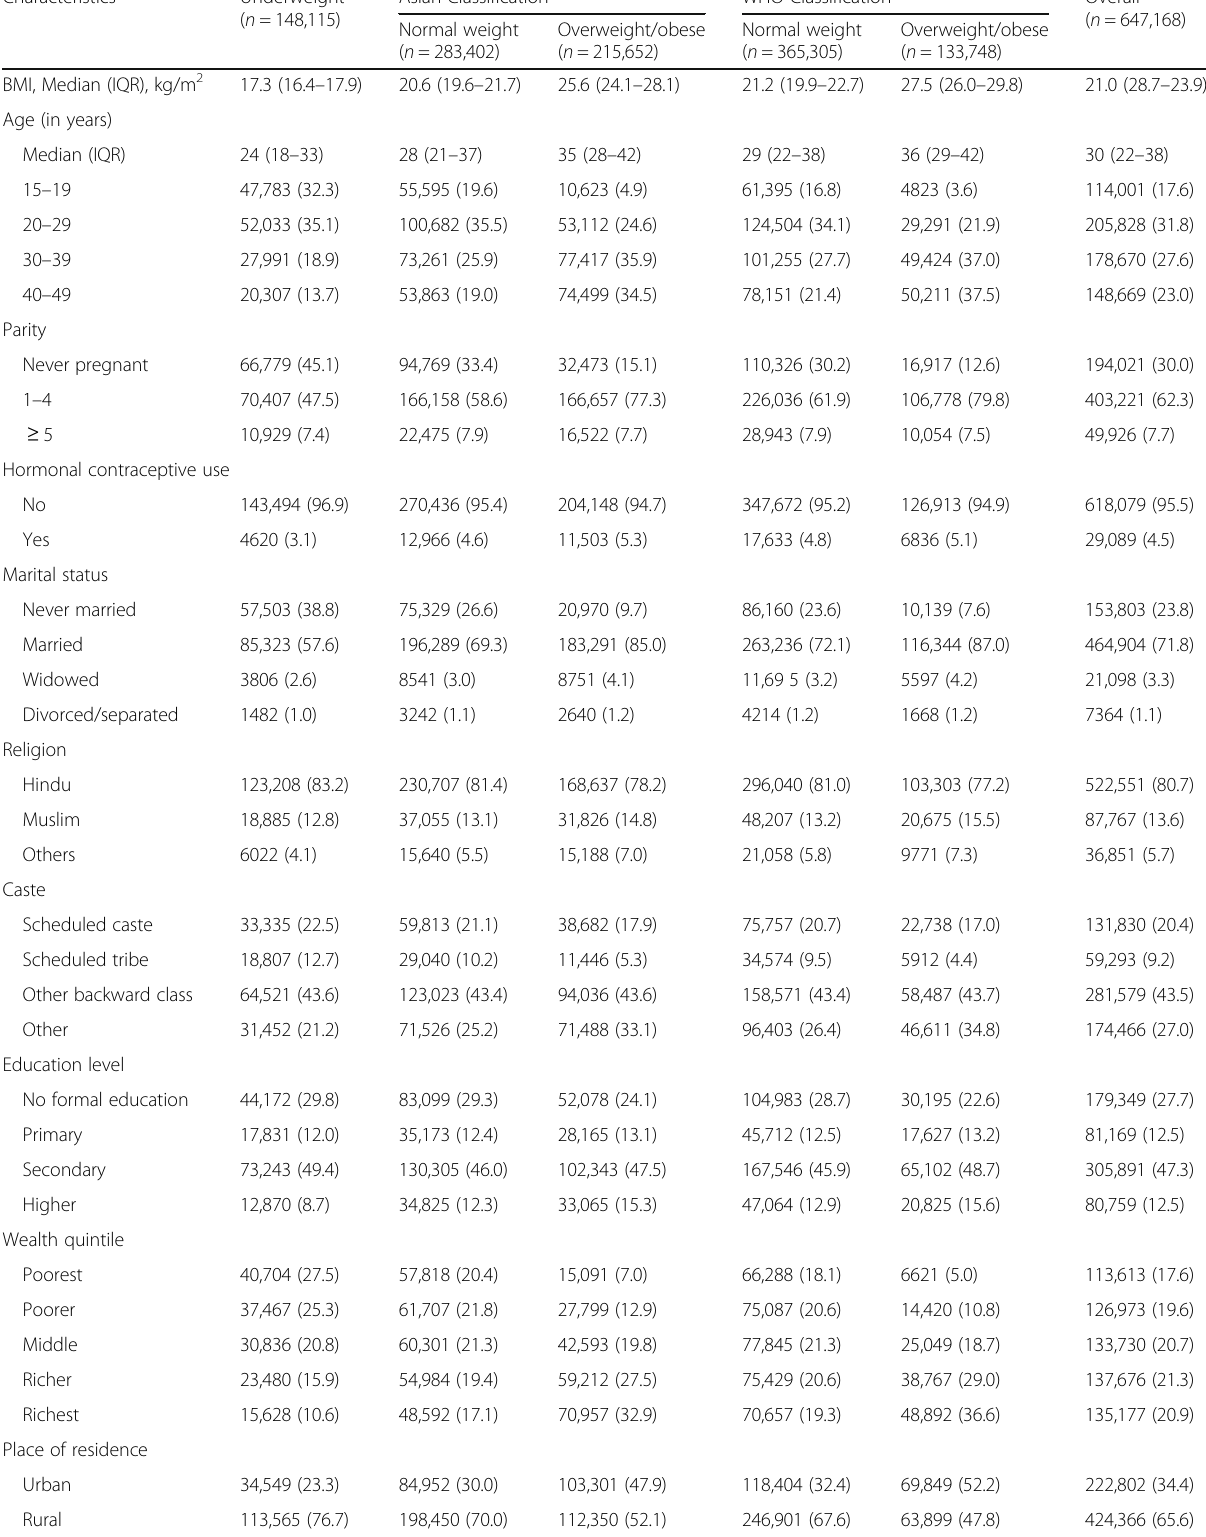
Table 1 Background characteristics of the survey participants according to body weight categories classified by guidelines 1